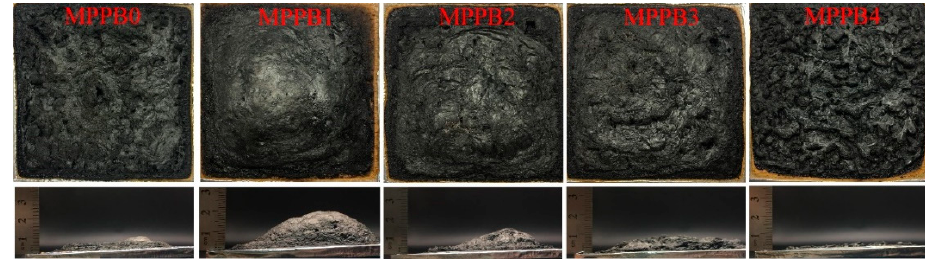
Figure 9. Digital photographs of the MPPBs char after the cone calorimeter test.